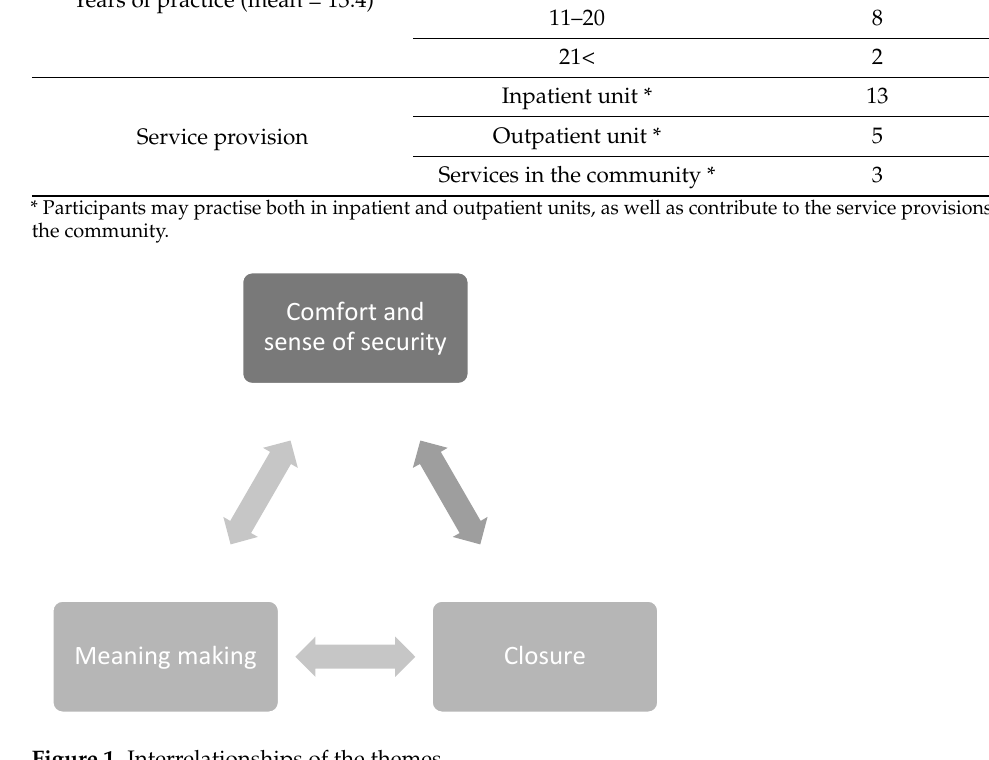
Figure 1. Interrelationships of the themes. Table 1. Respondents’ characteristics.